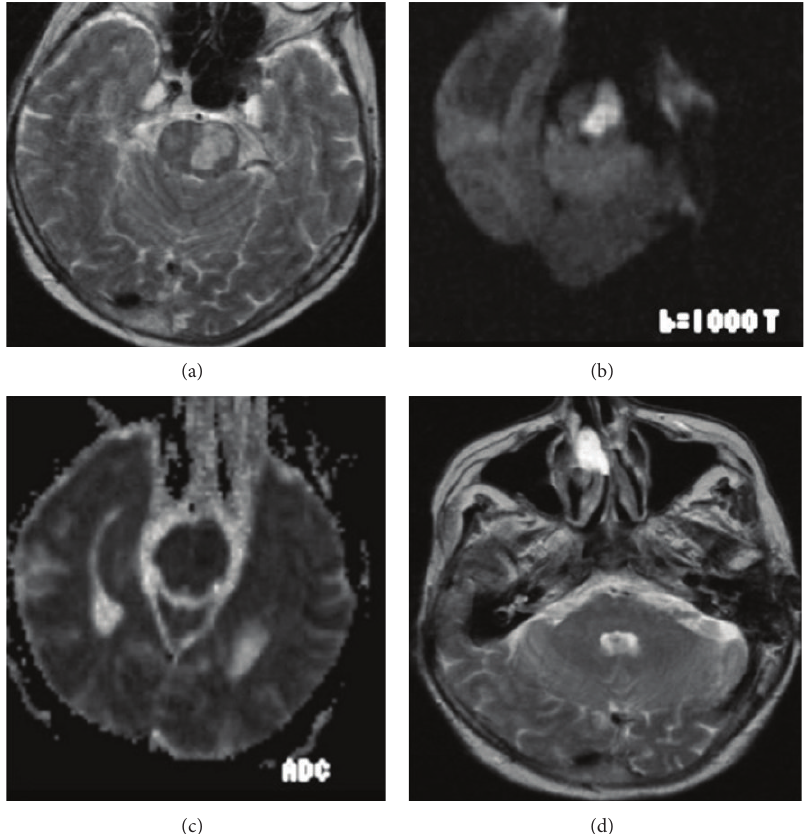
Figure 1: Left paramedian acute pontine infarction: axial T2WI (a) hyperintense signal on the left side of the pons, axial DWI (b) and ADC maps (c) restricted diffusion, and axial T2WI (d) MCPs were